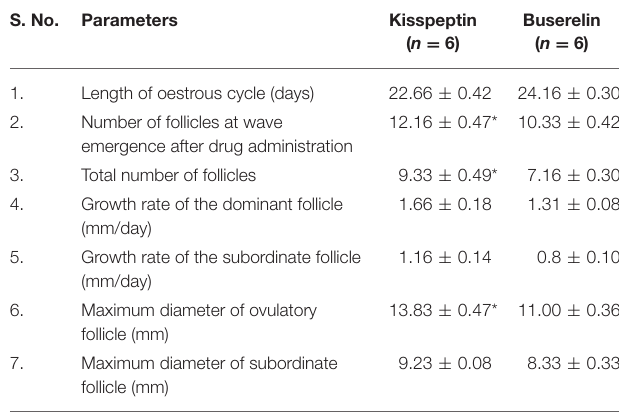
TABLE 2 | Effect of kisspeptin and buserelin on follicular dynamics in adult Murrah buffaloes. S. No.